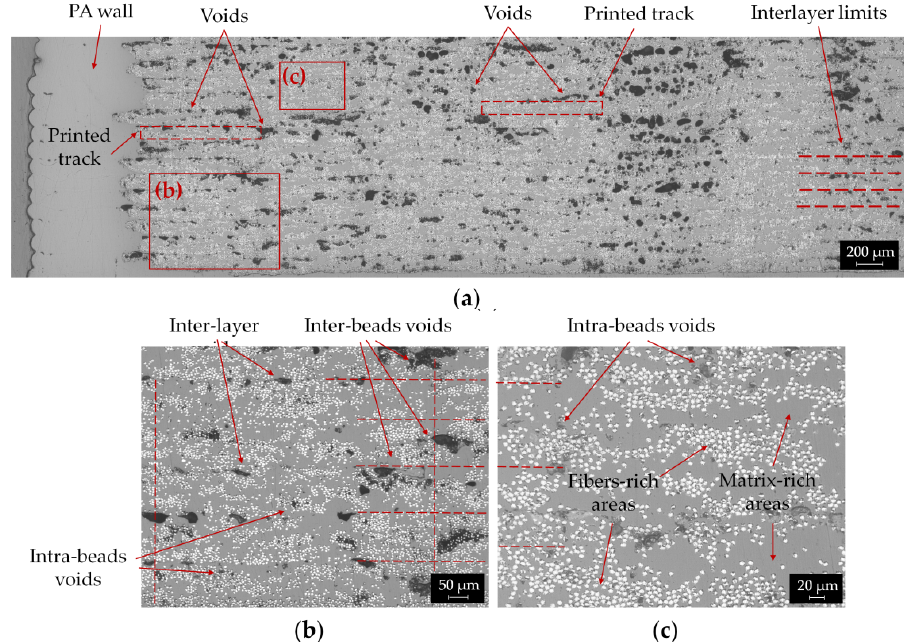
Figure 6. Cross-sectional optical micrographs of a longitudinal CCF/PA composites sample at various magnification levels: ( a ) panoramic view; ( b ) magnified view highlighting interlayer limits (horizontal dashed lines), beads interfaces (vertical dashed lines) and different types of voids (intra and inter layers); ( c ) intra-beads regions with alternated matrix-rich and fibers-rich